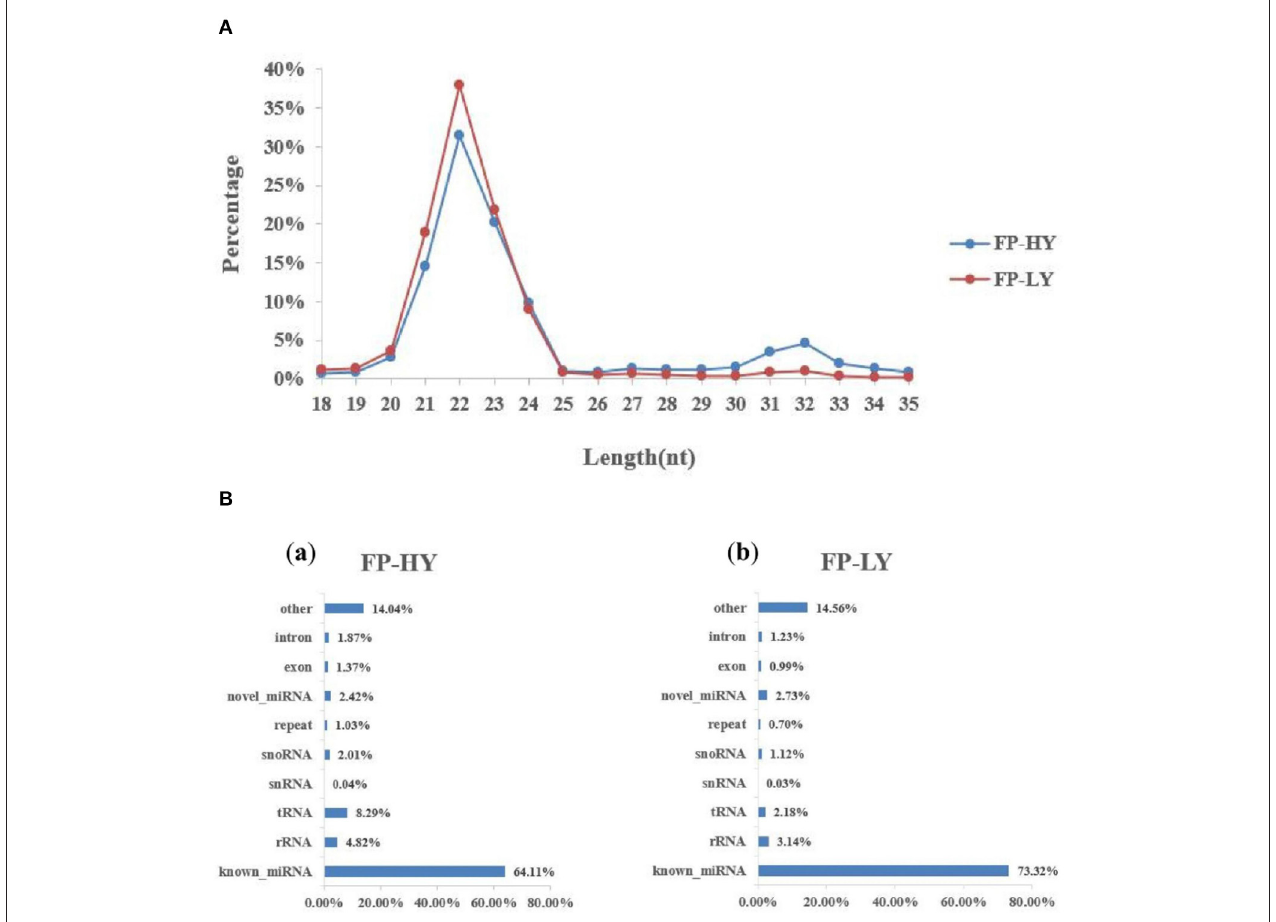
FIGURE 2 | Length distribution of small RNA reads and the percentage of detected miRNAs from NcRNAs. (A) Length distribution of clean reads from sRNA fragments. (B) Categories of identified non-coding RNAs (NcRNAs) by sequencing in FP-HY (a) and FP-LY (b).